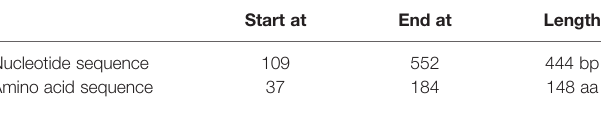
TABLE 1 | Nucleotide and Amino acid positions of the selected Rv1566c-444 enriched with T-cell epitopes.